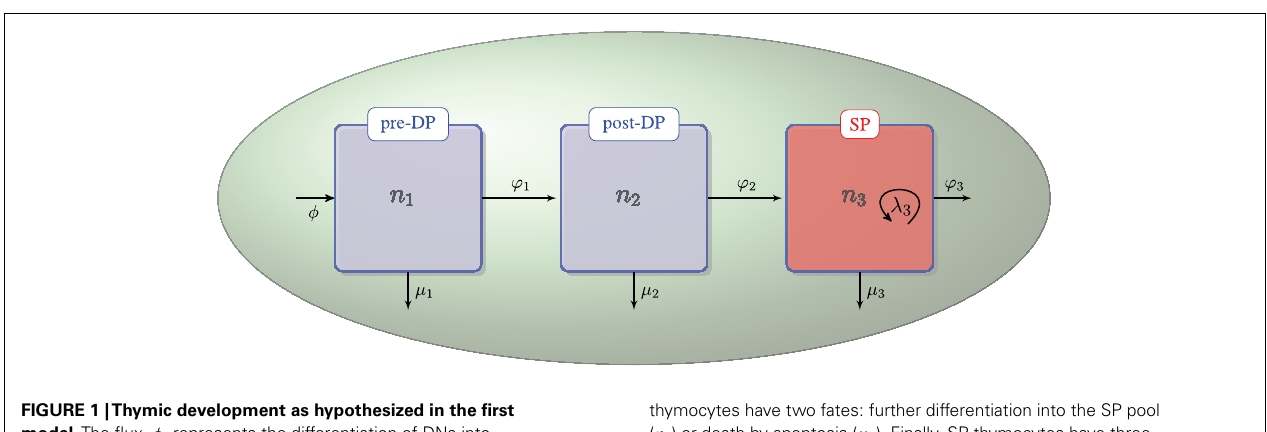
FIGURE 1 |Thymic development as hypothesized in the first model .The flux, φ , represents the differentiation of DNs into pre-DPs. Pre-DP thymocytes have two fates: further differentiation into the post-DP pool ( ϕ 1 ) or death by neglect ( µ 1 ). Post-DP